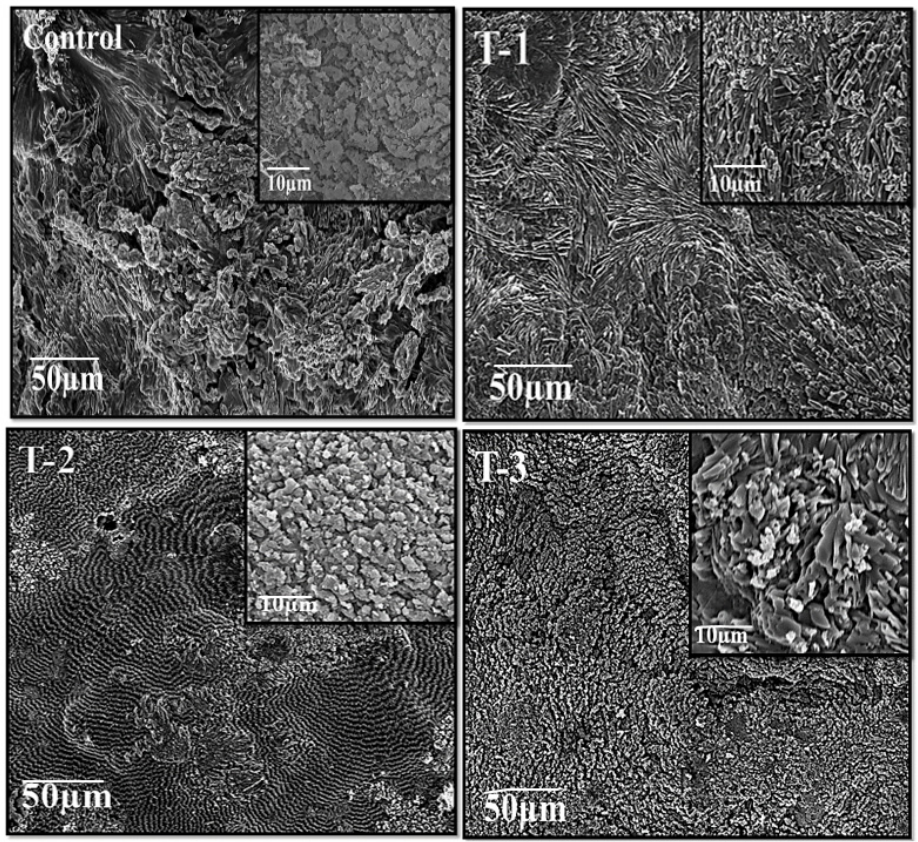
Figure 2. Scanning electron microscope (SEM) images of Control; T-1: (SA:SE 70:30); T-2: (SA:SE 80:20); and T-3: (SA:SE 90:10) hydrogels at × 1000 and × 2500 magnifications.